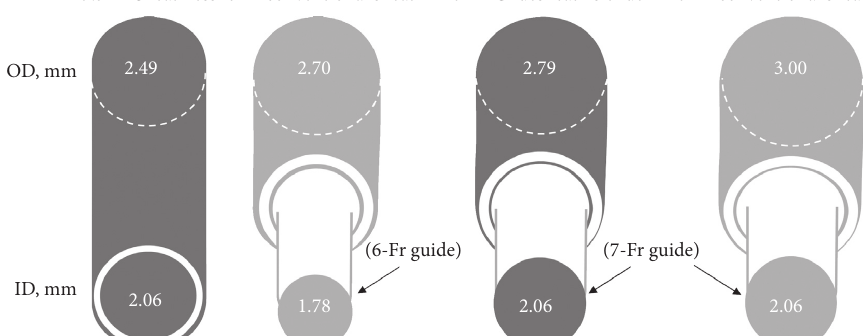
Figure 1: Comparison of the outer diameter and inner lumen diameters among the Glidesheath slender sheath, sheathless guiding catheter, and conventional sheath (illustration prepared by the authors with reference to the Glidesheath slender ® sheath and Sheathless Eaucath ® information brochures). “Glidesheath slender” denotes a Glidesheath slender sheath, and “Sheathless” denotes a sheathless guiding catheter. ID, inner lumen diameter; OD, outer